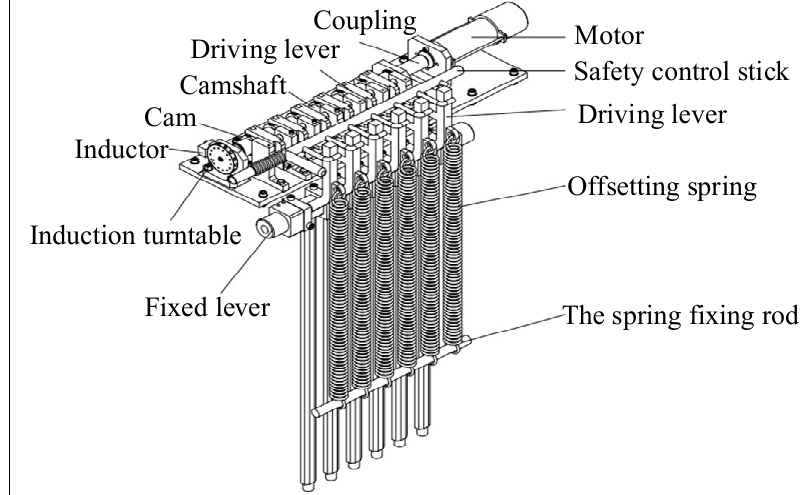
Camshaft Figure 4. Driving schematic diagram of the net opening and closing mechanism.